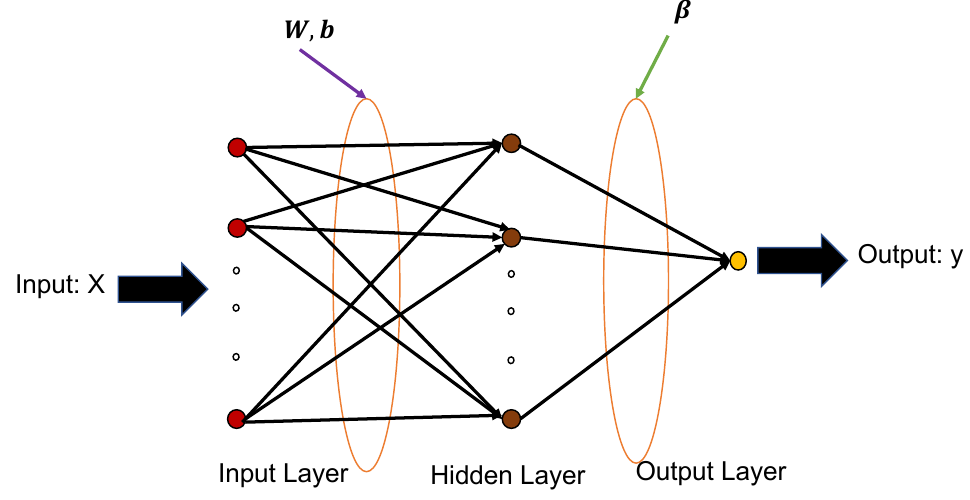
Figure 1. A single-layer feed-forward